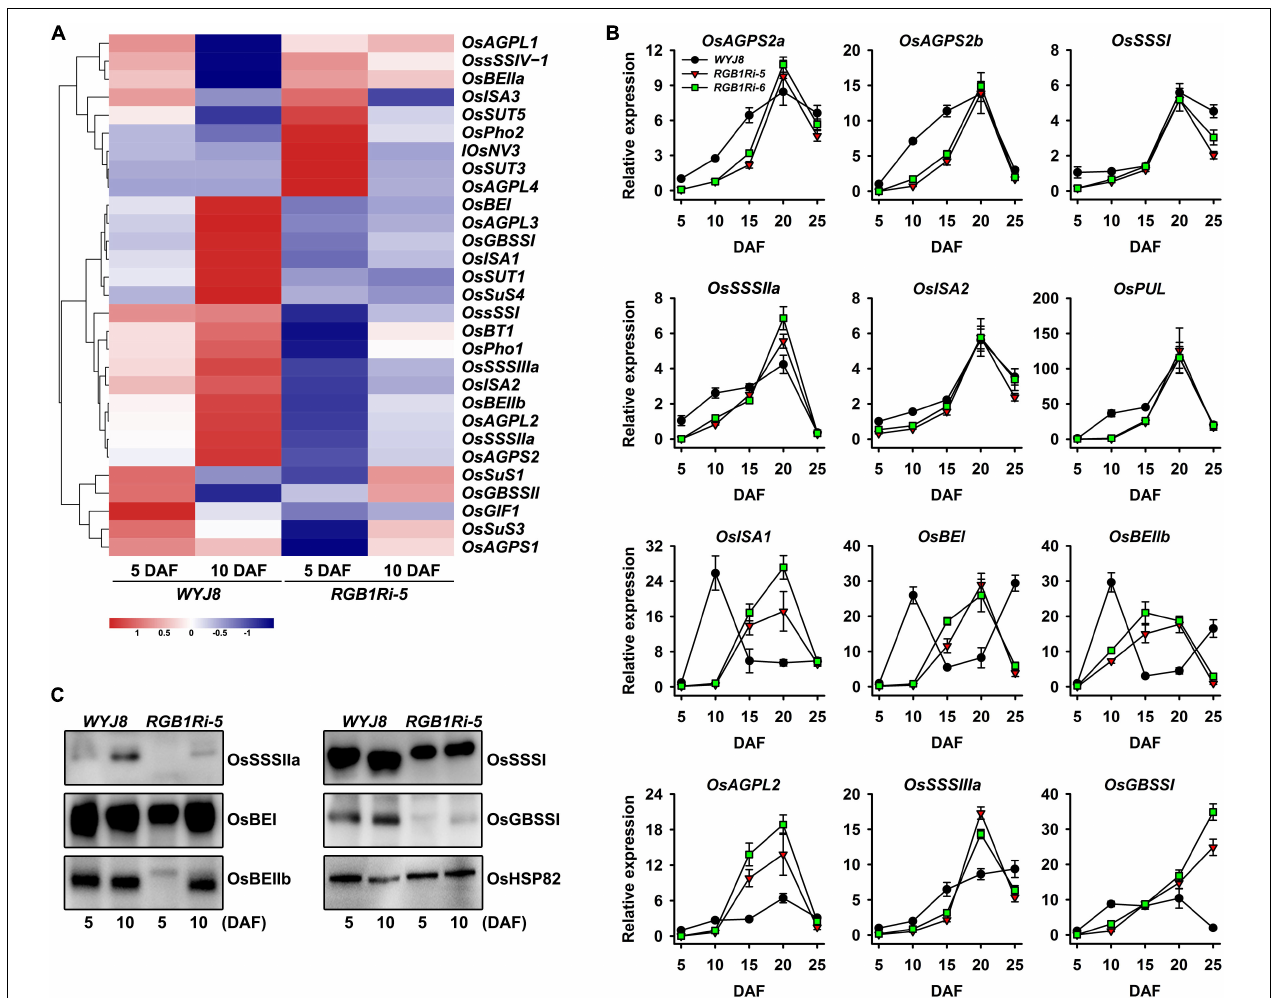
FIGURE 2 | Expressional profiles of sucrose metabolism and starch synthesis related genes during grain filling stage of WYJ8 plant and RGB1Ri lines . (A) Heat maps of differentially expressed genes (DEGs) involved in the starch biosynthesis. The maps were plotted using the value of RPKM for each gene in the different samples: blue indicates low values; red indicates high values. The indicated scale is the log2 value of the normalized level of gene expression. (B) qRT-PCR analysis showing the changes of genes encoding sucrose metabolism and starch biosynthesis-related enzymes during grain filling (from 5 to 25 DAF). (C) Western blotting assay showing the changes of the levels of several enzymes/proteins related to starch biosynthesis at the early stage of grain filling (5 and 10